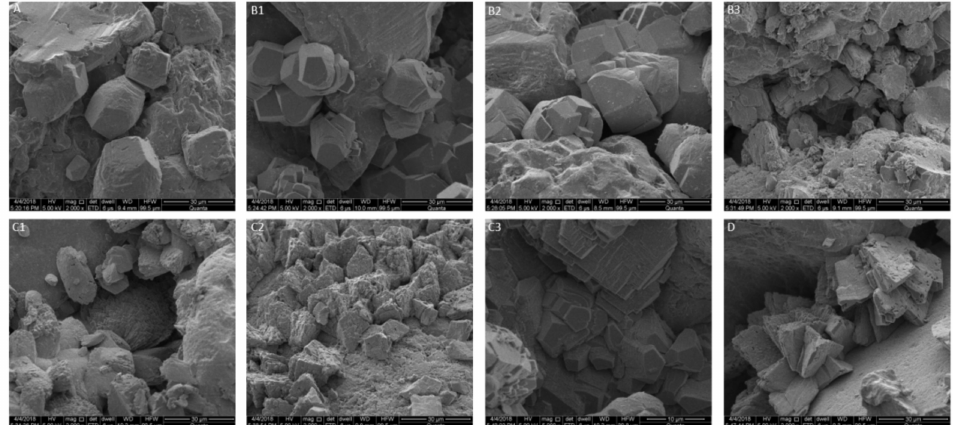
Figure 9. Calcium carbonate crystal form of sand solidified with various nutrient solutions. Calcium carbonate crystal form of group A ( A ); Calcium carbonate crystal form of group B1 ( B1 ); Calcium carbonate crystal form of group B2 ( B2 ); Calcium carbonate crystal form of group B3 ( B3 ); Calcium carbonate crystal form of group C1 ( C1 ); Calcium carbonate crystal form of group C2 ( C2 ); Calcium carbonate crystal form of group C3 ( C3 ); Calcium carbonate crystal form of group D ( D